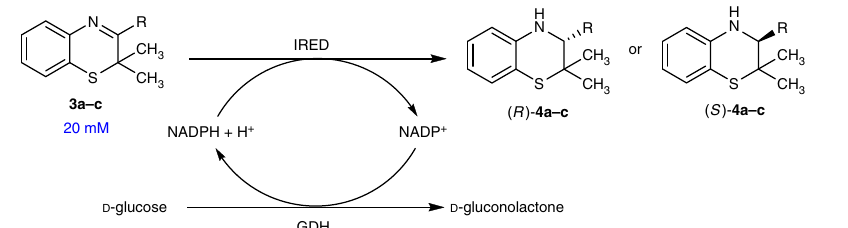
Fig. 5 Imine reductase-catalyzed reduction of 2 H -1,4-benzothiazines